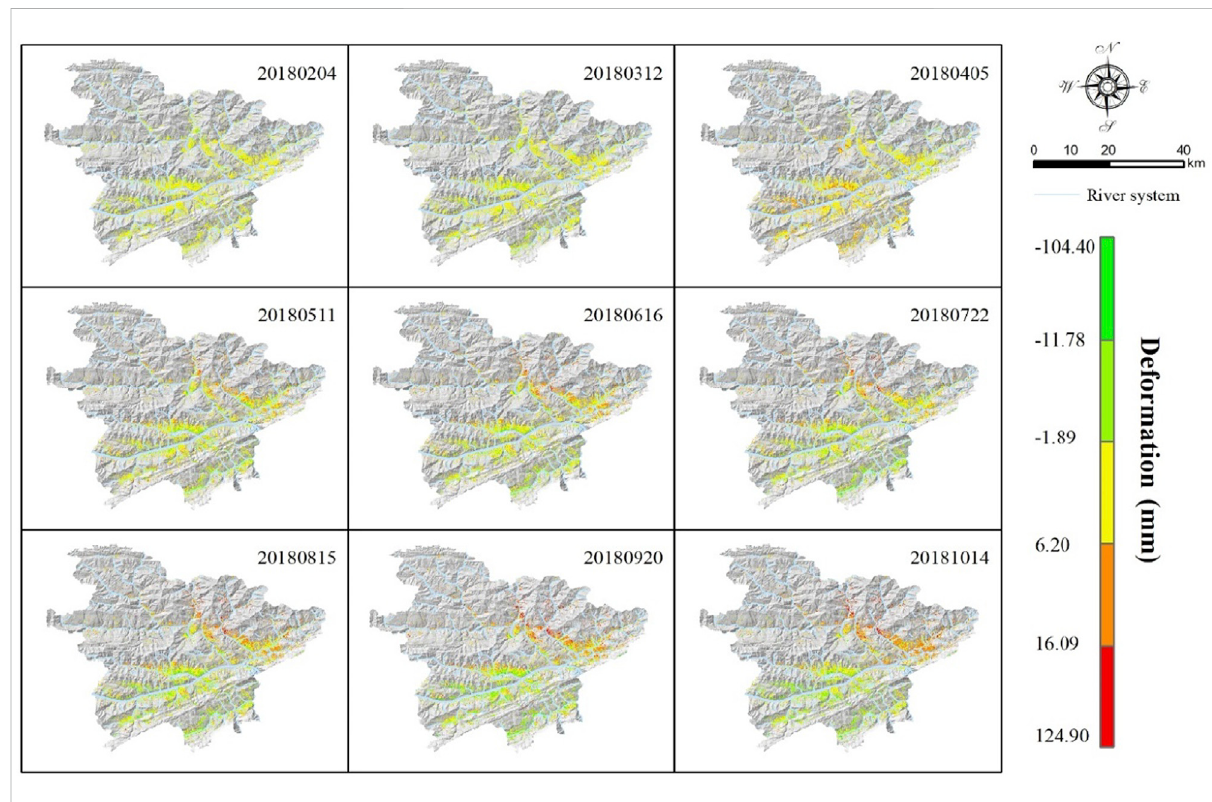
FIGURE 11 Partly surface deformation in short-time series in 2018.